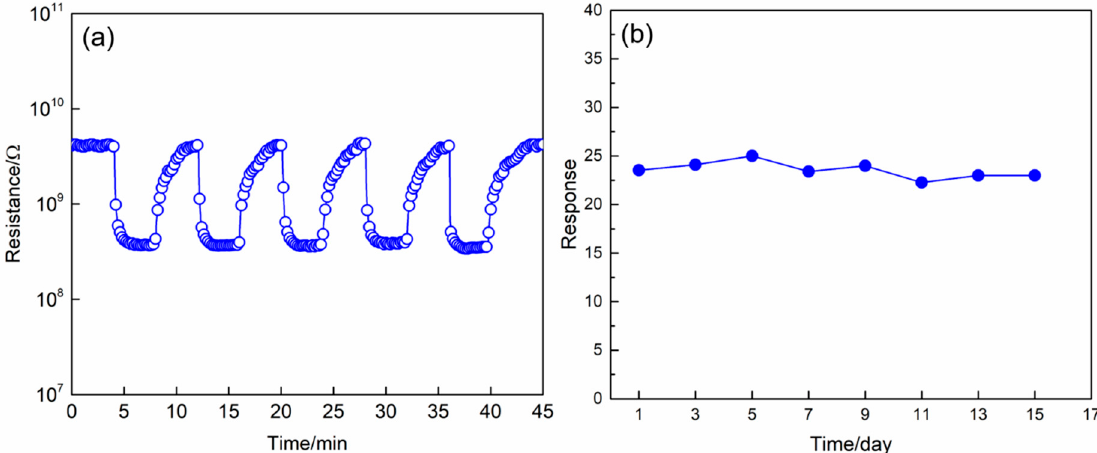
Figure 10. ( a ) Dynamic response and recovery curves of 1% Zn-doped α -Fe 2 O 3 nanowires upon exposure to 5 ppm H 2 S for five cycles at the operating temperature of 175 °C. ( b ) Long-term stability of the sensor based on 1% Zn-doped α -Fe 2 O 3 nanowires upon exposure to 5 ppm H 2 S at the operating temperature of 175 °C.